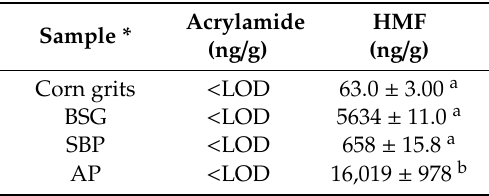
Table 2. Acrylamide and HMF contents in raw materials.